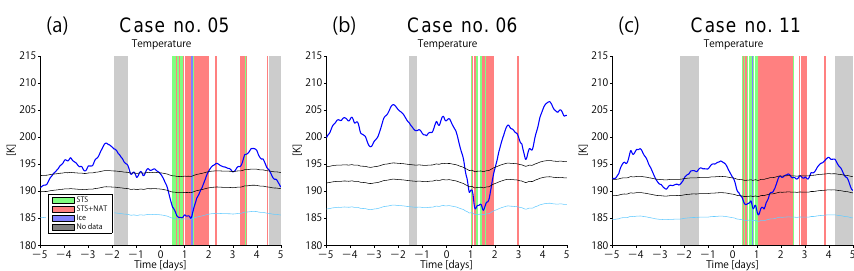
Figure 6. Same as Fig. 5 but for trajectory case no. 05 (a) , starting at 17:53:38UT on 30 December 2009 at an altitude of 22.97km; no. 06 (b) , starting at 08:58:26UT on 31 December 2009 at an altitude of 21.00km; and no. 11 (c) , starting at 17:41:15UT on 1 January 2010 at an altitude of 24.05km, respectively.